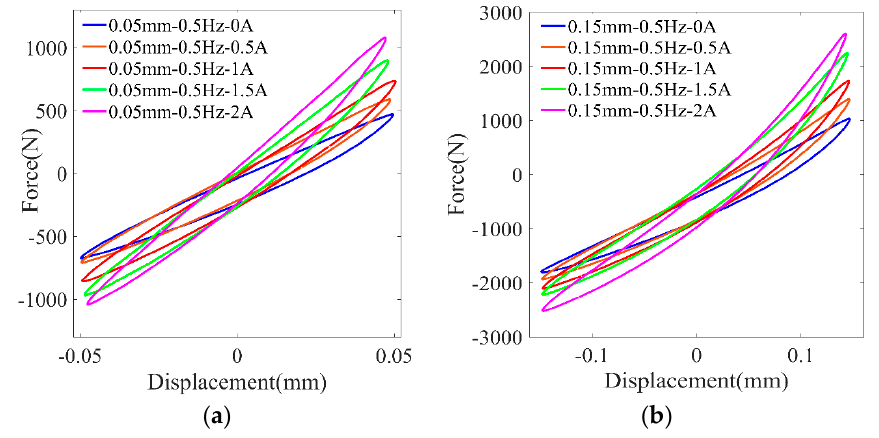
Figure 3. Hysteresis loops of MRE isolator in various applied currents: ( a ) A = 0.05 mm; ( b ) A = 0.15 mm.